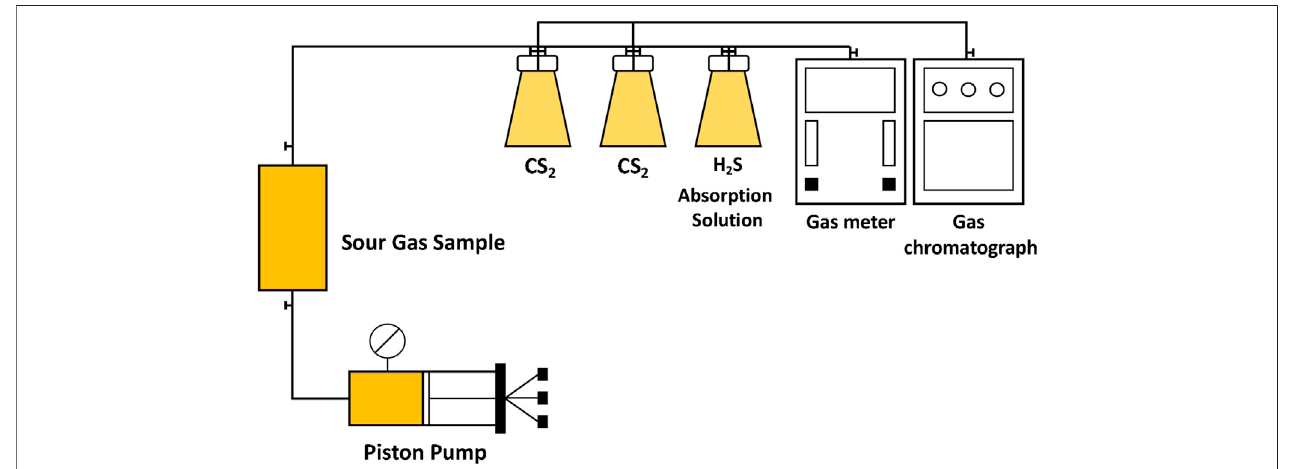
FIGURE 1 | The experimental apparatus for measuring elemental sulfur content